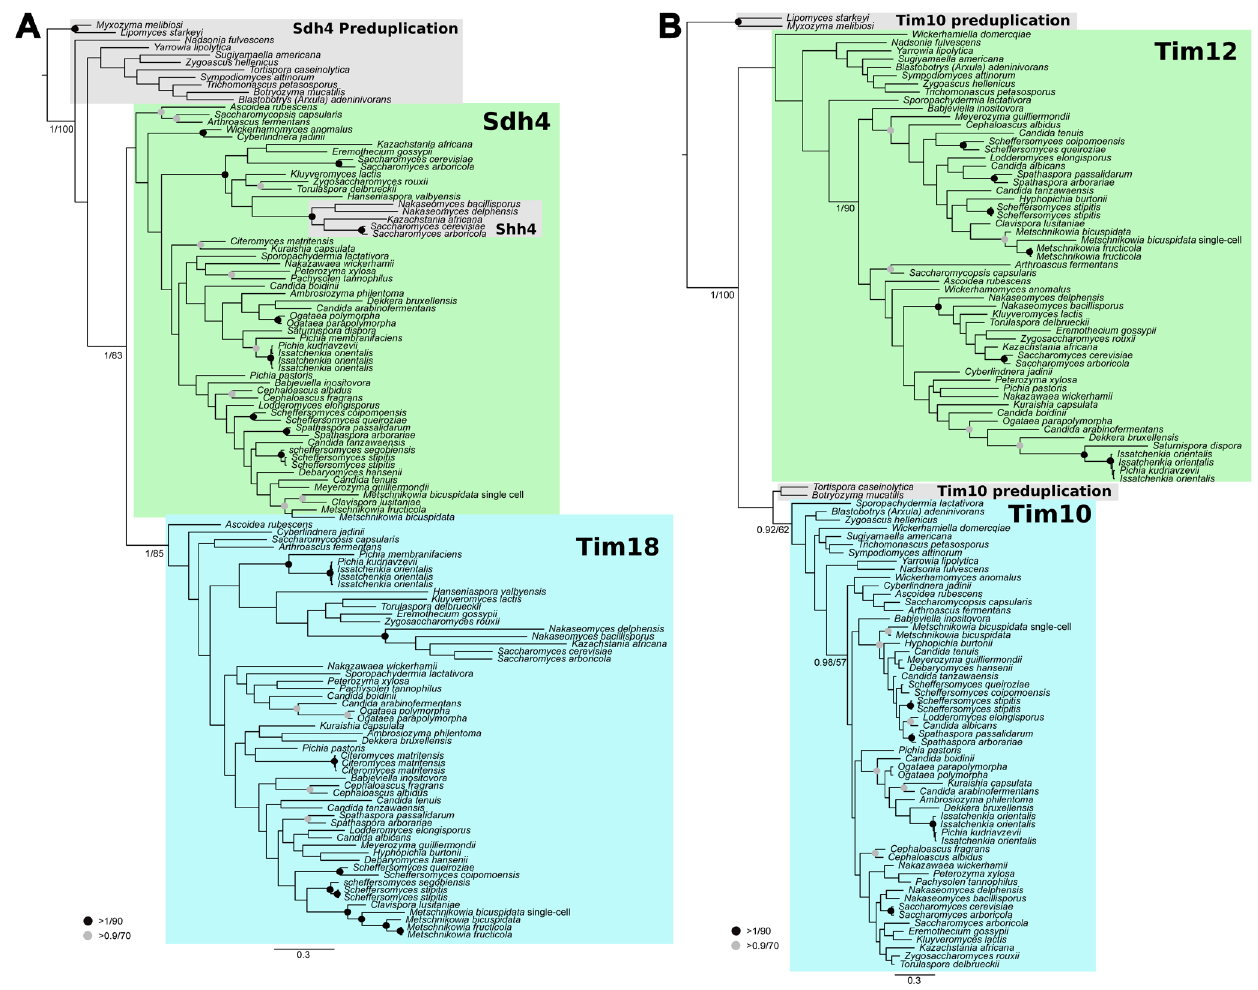
Figure 3. Phylogenetic analysis of Saccharomycotina TIM22 subunits. ( A ) Tim18 arose from a duplication of Sdh4 deep within the yeast lineage. ( B ) Tim12 arose from a duplication of Tim10 near the base of Saccharomycotina. Homologues of Tim18/Sdh4 and Tim10/12 were collected from sequenced Saccharomycotina on Mycocosm (Grigoriev et al., 2013) using BLASTp. Sequences were aligned and trimmed resulting in 128 and 82 sites for Tim18 and small tims, respectively. The resulting alignments were subjected to phylogenetic analysis using MrBayes (Ronquist et al., 2012) for posterior probability and RAxML (Stamatakis, 2014) for maximum likelihood